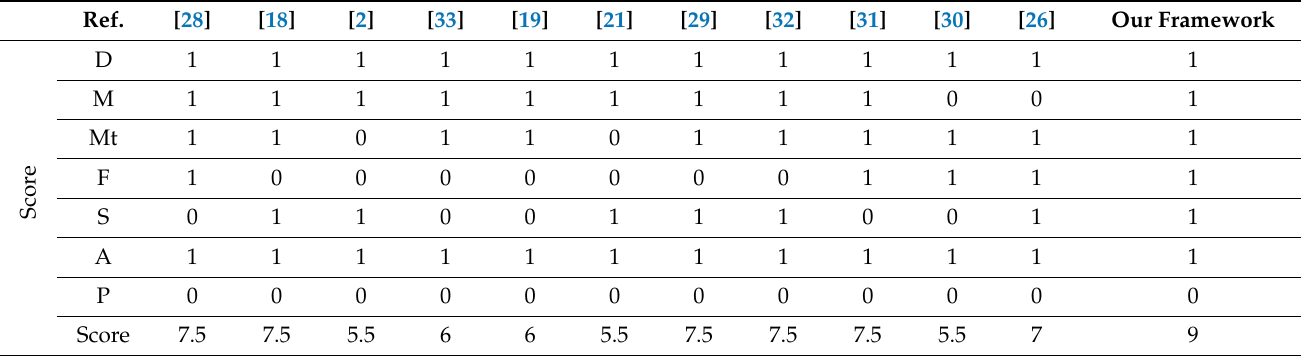
Table 12. Comparative table of the frameworks and their